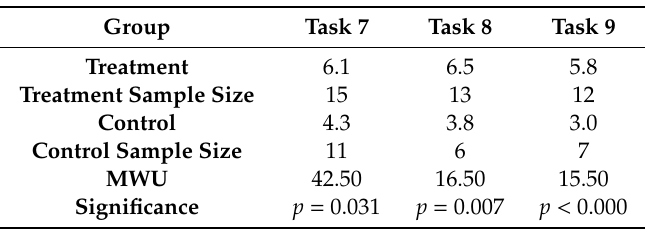
Table 10. Website text emotion tasks